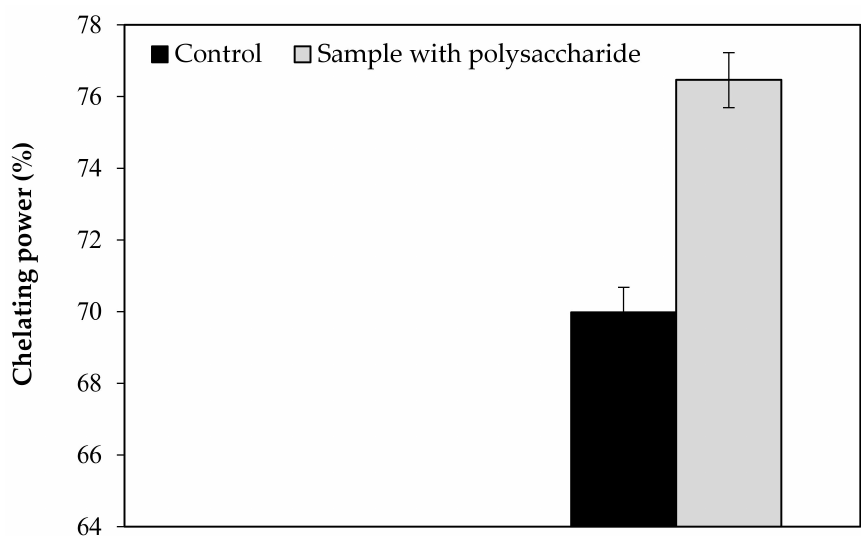
Figure A4. Effect of KWSP on Chelating